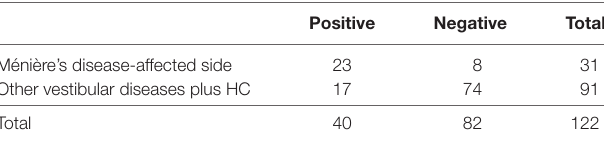
Table 4 | sensitivity and specificity to other vestibular disease patients plus healthy controls (hc).